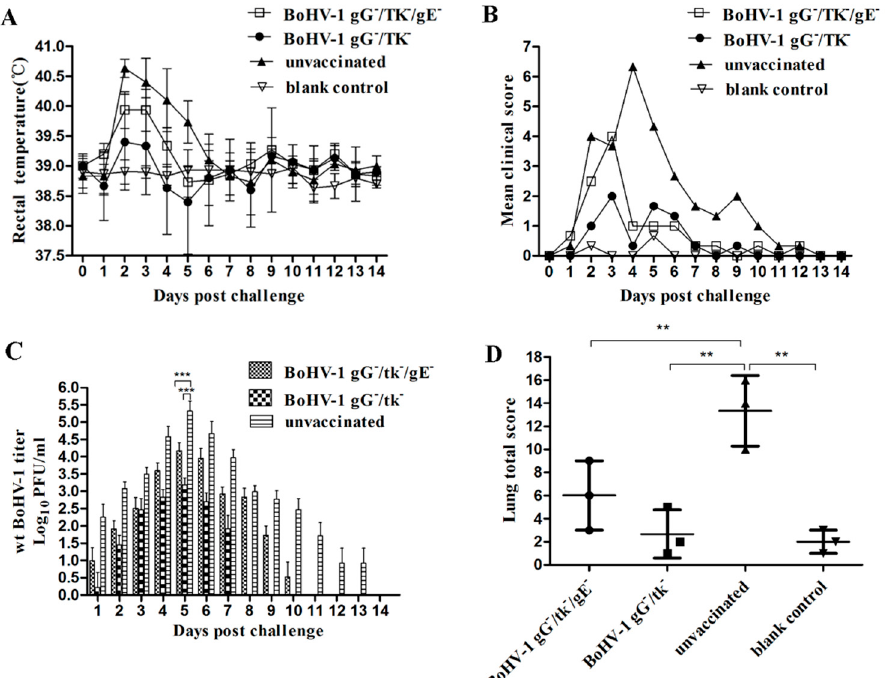
Figure 4. Protective efficacy of BoHV-1 gG-/tk-/gE- against wt BoHV-1 ( A – D ) challenge in calves. ( A ) Temperature change. ( B ) Clinical scores. ( C ) Nasal virus shedding. ( D ) Lesion scores of lungs. The mark (**) with p < 0.01 and (***) with p < 0.001 were considered to indicate a significant or high significant statistical difference respectively.